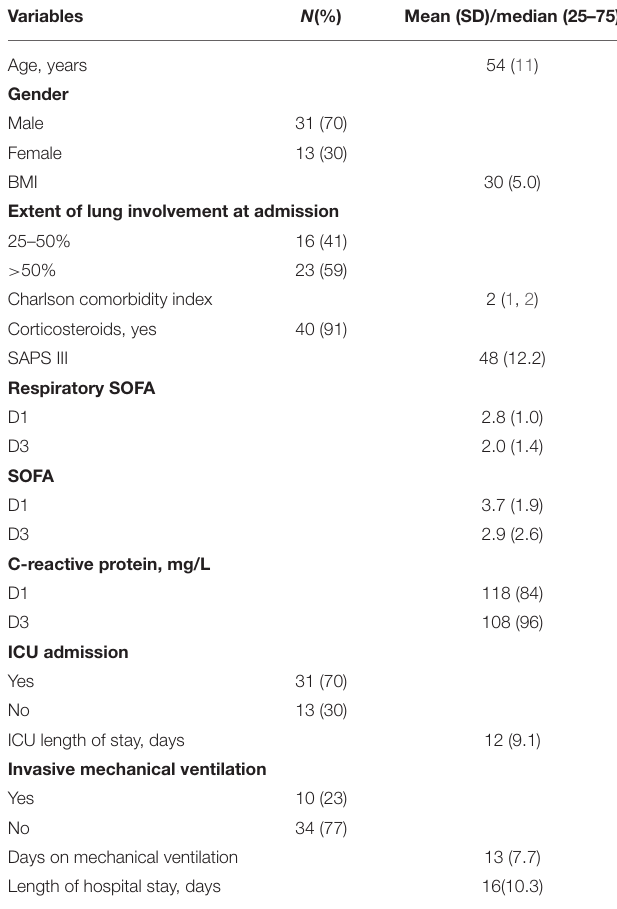
TABLE 1 | General patients’